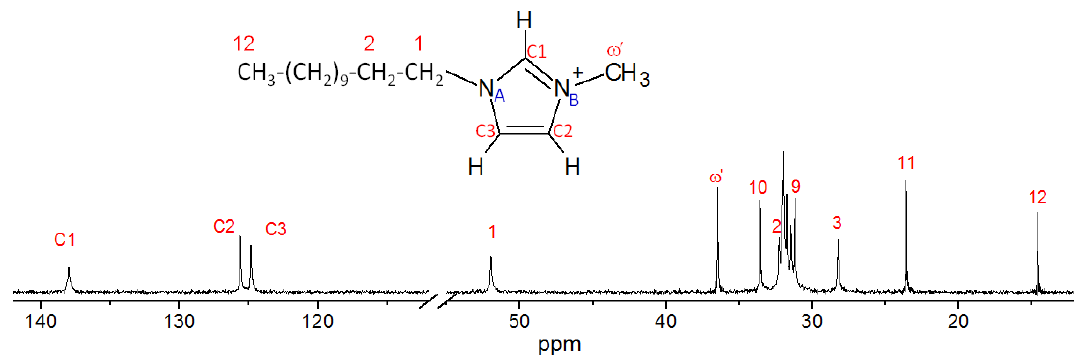
Figure 1. Carbon-13 cross-polarization (CP) spectrum of C 12 mimBF 4 at 38 °C in smectic A phase. Spectrum is superposition of two spectra obtained with decoupler offset optimized either for aromatic or aliphatic carbons.